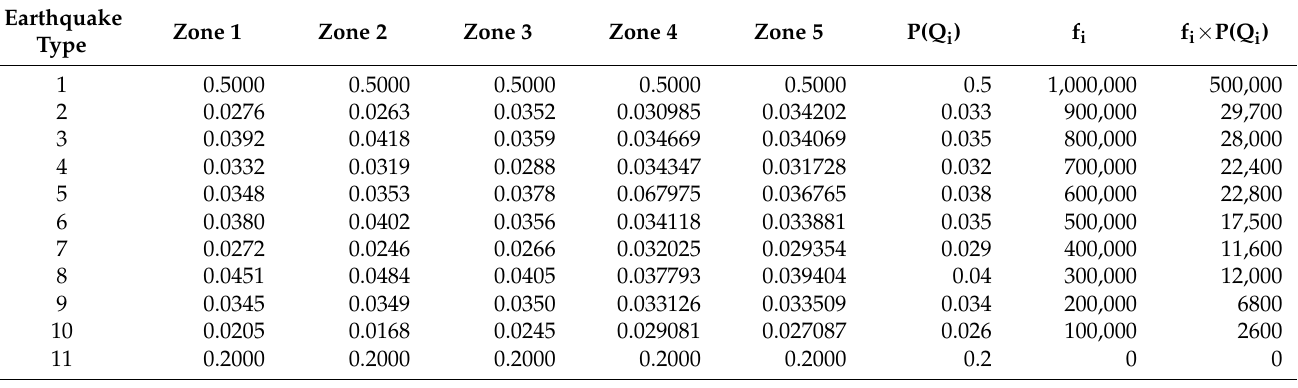
Table 28. The calculated result of probability type-i and expectation of face amount for clustering type